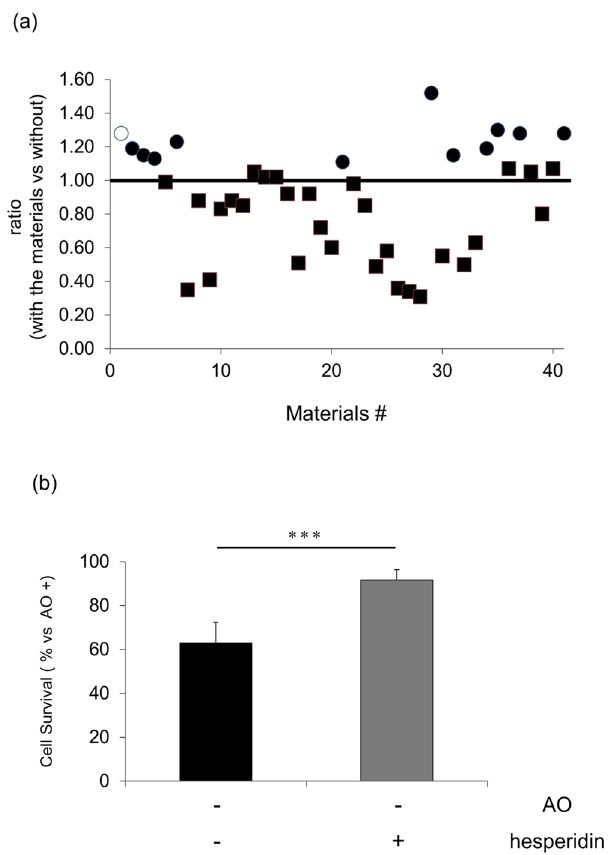
Figure 1. Anti-oxidant compound screening with a mouse retinal primary culture. ( a ) Primary retinal cells were cultured for 18 h under oxidative stress without an antioxidant supplement, in media containing candidate materials. Cell viability was then assessed with an Alamar blue assay. The Y-axis shows the ratio of fluorescence intensity in these cultures, with the intensity of cultures without candidate materials set as 1.0. Individual materials that significantly increased cell viability are represented by black circles ( ⚫ ) and materials that did not significantly increase cell viability are represented by squares ( ◾ ). Hesperidin is represented by a white circle ( ⚪ ). ( b ) Primary retinal cells were cultured with 0.05% hesperidin, and cell viability was assessed with an Alamar blue assay. Fluorescence intensity was measured and the value was normalized as the percentage of the intensity of culture containing an antioxidant supplement. Data represent mean ± SD ( n = 6 each). *** p <